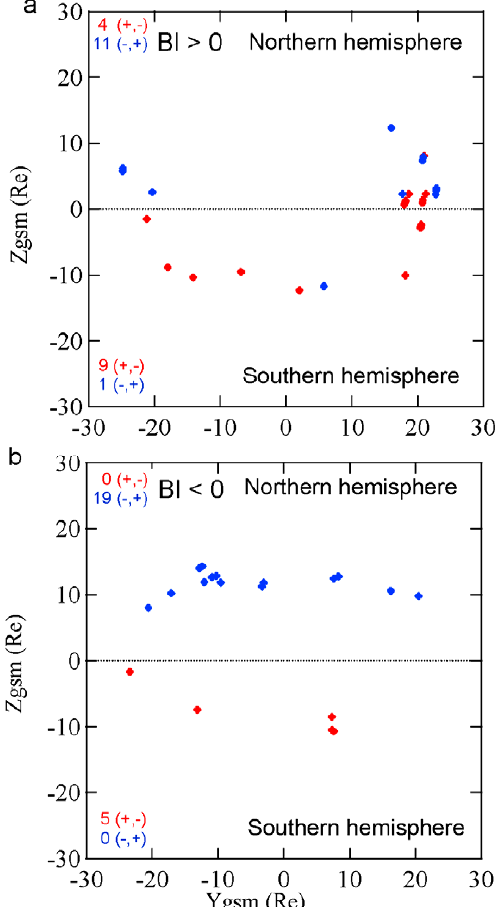
Fig. 12. Locations of magnetosphere FTEs with direct and reverse signatures for R E > 10 R E for northward and southward Bl magne- tosheath magnetic fields, respectively. Red and blue crosses denote direct ( + , − ) and reverse ( − , + ) signatures in Bn component.